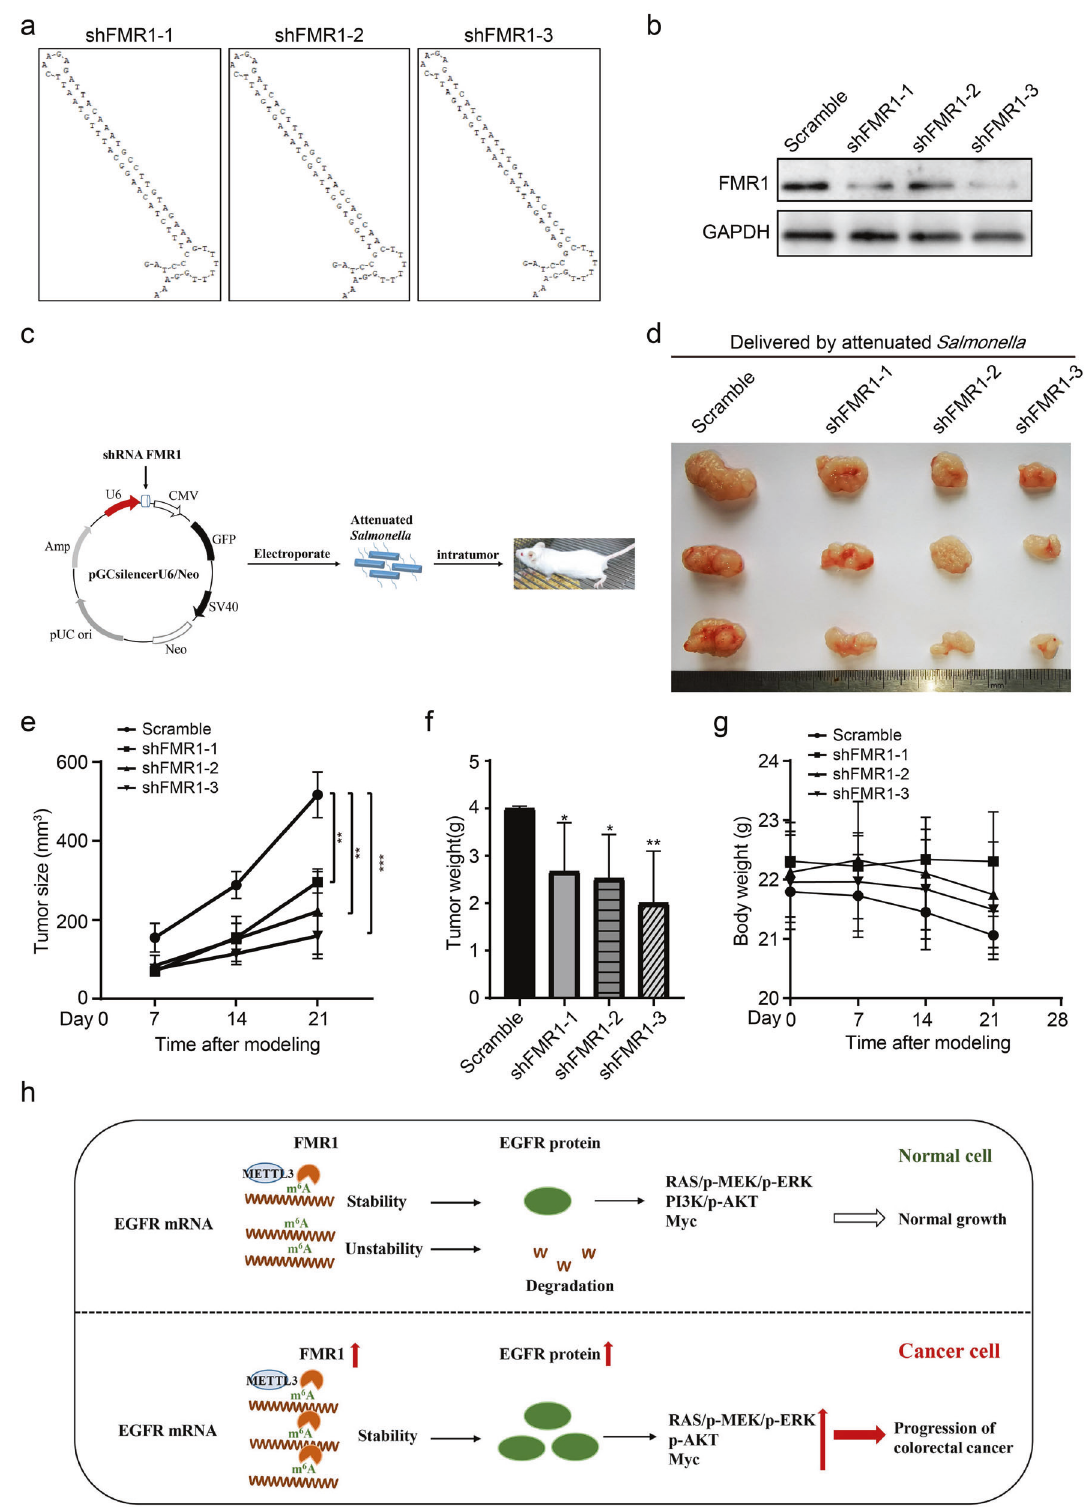
Fig. 7 FMR1 shRNA carried by attenuated Salmonella can effectively cure colon cancer in vivo. a Local secondary structure of FMR1 mRNA at the regions targeted by the three FMR1 small interfering RNAs. b Western blot was used to validate the expression of FMR1 in CT26 cells with FMR1 shRNA. c Schematic of subcutaneous tumor formation assay in CT26 mice formed by CRC cells with FMR1 shRNA carried by attenuated Salmonella . d Images of the representative tumors in each group on posttreatment 14 days. e Tumor size analysis. f Tumor weight analysis. g Body weight analysis. h Proposed model underlying the effect of FMR1-medicated EGFR mRNA stability in colorectal cancer. Data are shown as means ± SD. * P < 0.05, ** P < 0.01, *** P < 0.001.